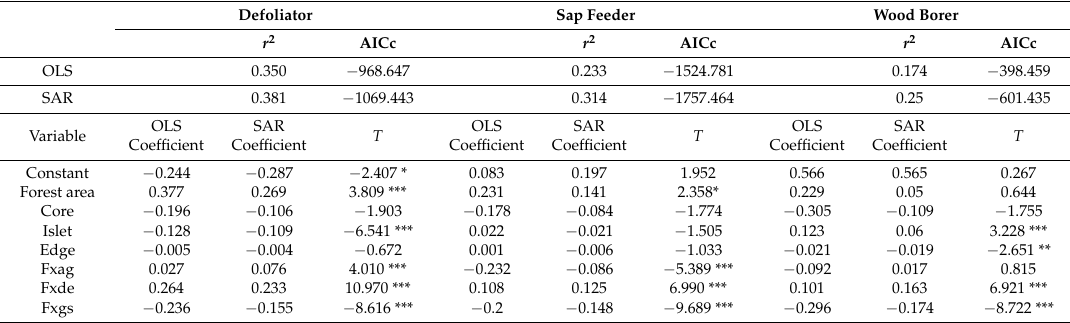
Table 4. Effects of forest fragmentation and edge types on insect pest richness (three guilds) across the forests in the conterminous United States based on the ordinary-least-squares (OLS) estimation and spatial autoregression analyses (SAR). Data were aggregated to the county level ( N = 2098) and were log (x+1)-transformed before analysis. Forests 2018 , 9 , x FOR PEER REVIEW 9 of 12 Defoliator Sap Feeder